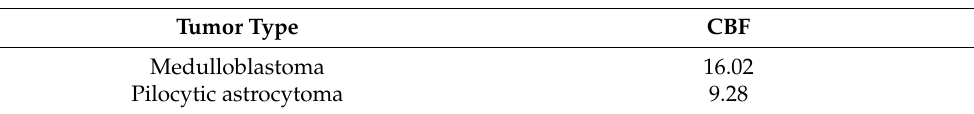
Table 4. Absolute CBF values (mL/100 g/min) for each tumor ROI [19]. Imaging Technique: Axial 3D Pseudo Continuous ASL with 16-Channel Head Coil in a 1.5 T